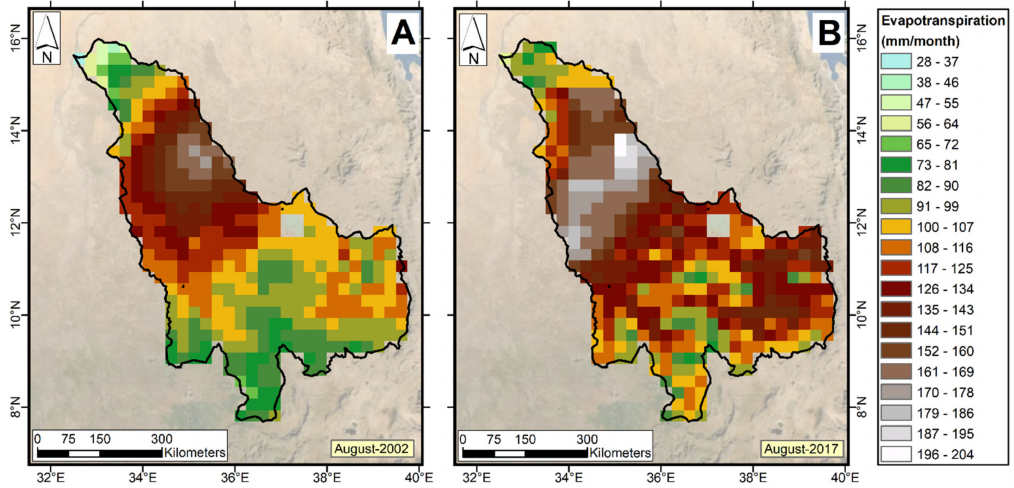
Figure 3. Evapotranspiration data from GLDAS-Noah V2 product for the Blue Nile, ( A ) August 2002; ( B ) August